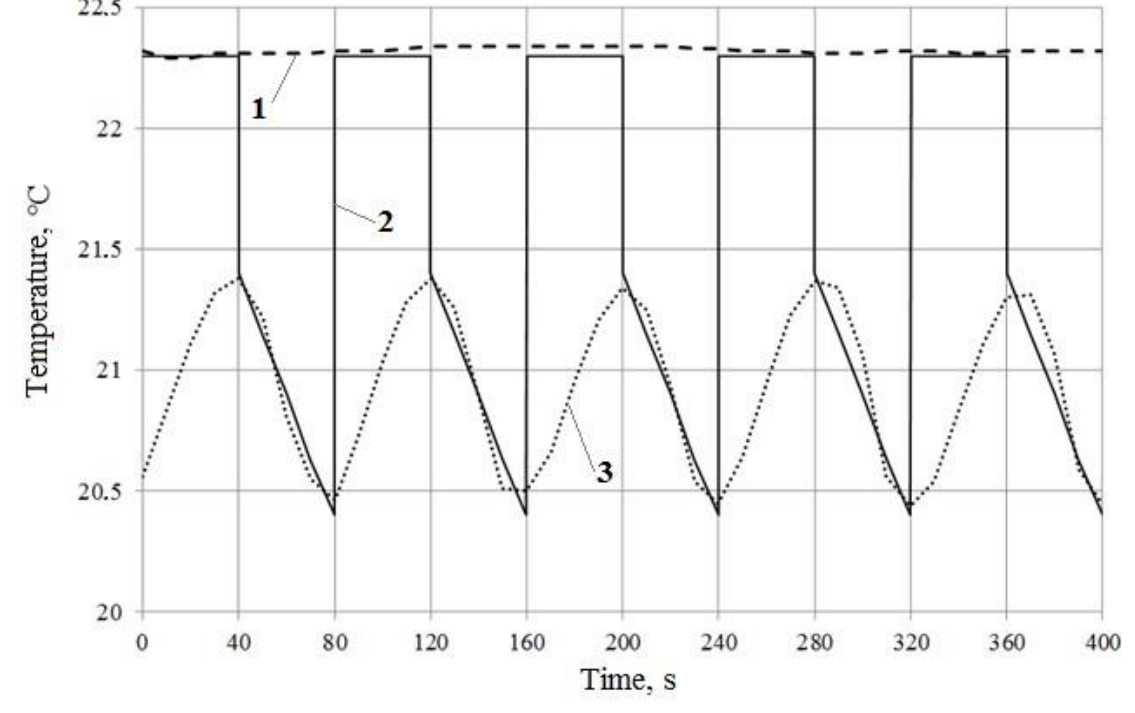
Figure 8. Comparison of experimental and calculated data on the change in air temperature at the inner end of the SSRHE: 1— T in , 2—calculation, 3—experiment.